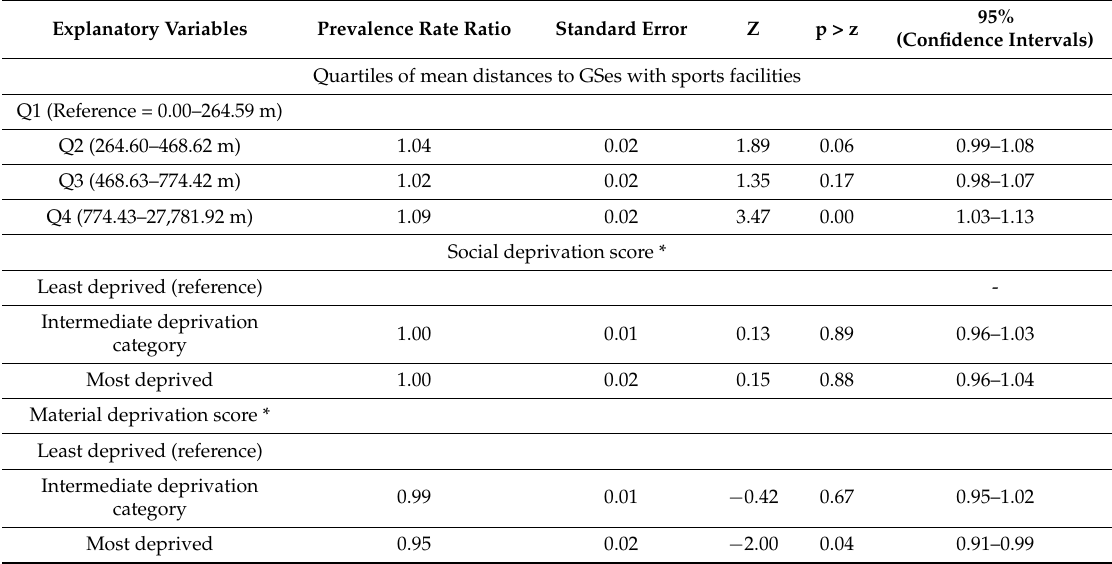
Table 3. Regression model of diabetes prevalence and green spaces that have sport facilities for adults ě 20 years living in Montreal and Quebec City CMAs, 2006 ´